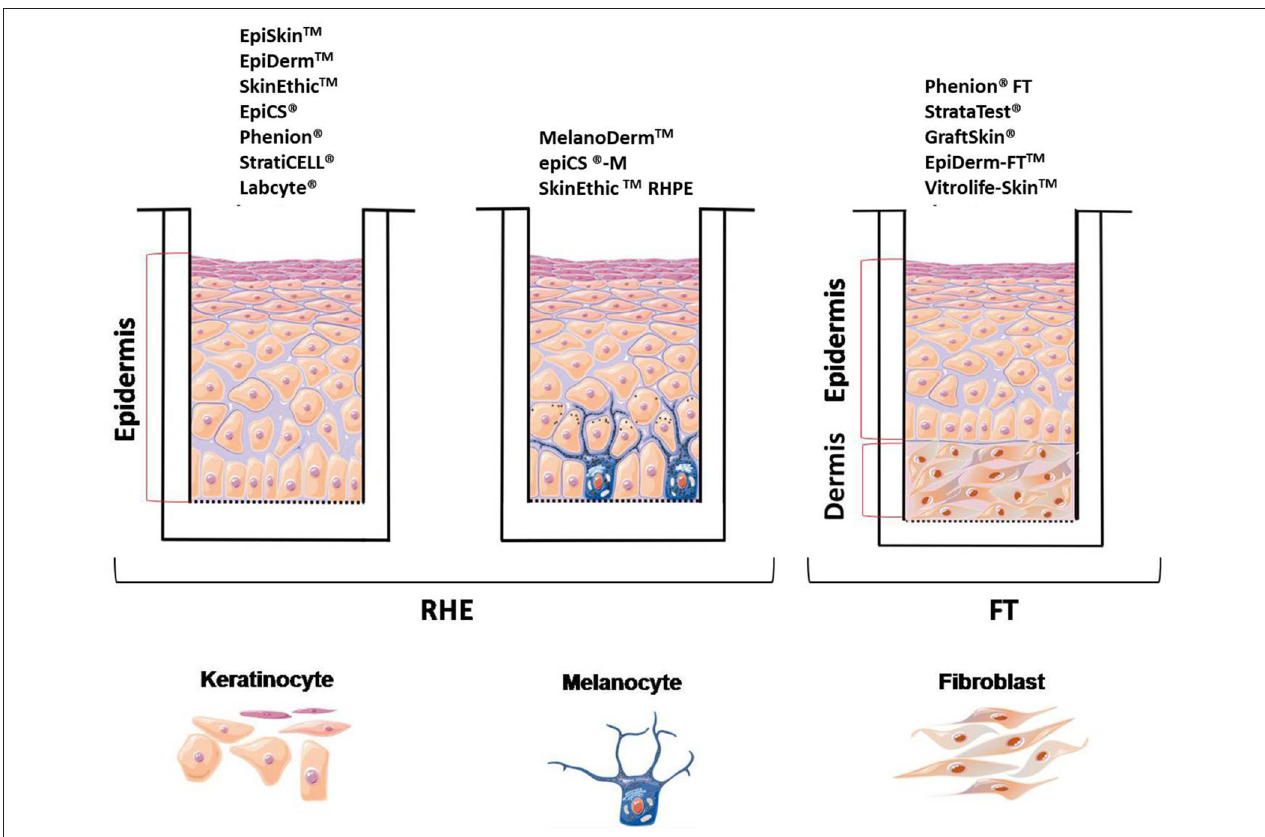
FIGURE 2 | Scheme of the main 3D skin models used. Image adapted from